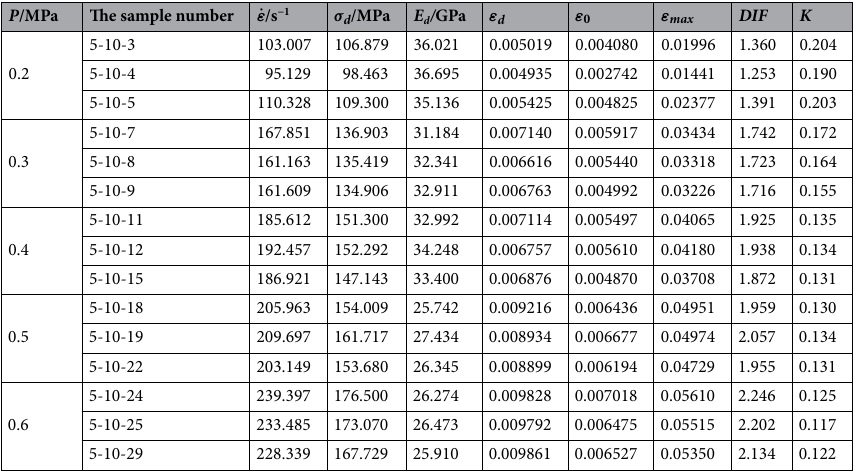
Table 2. Dynamic parameters of ore rock samples.